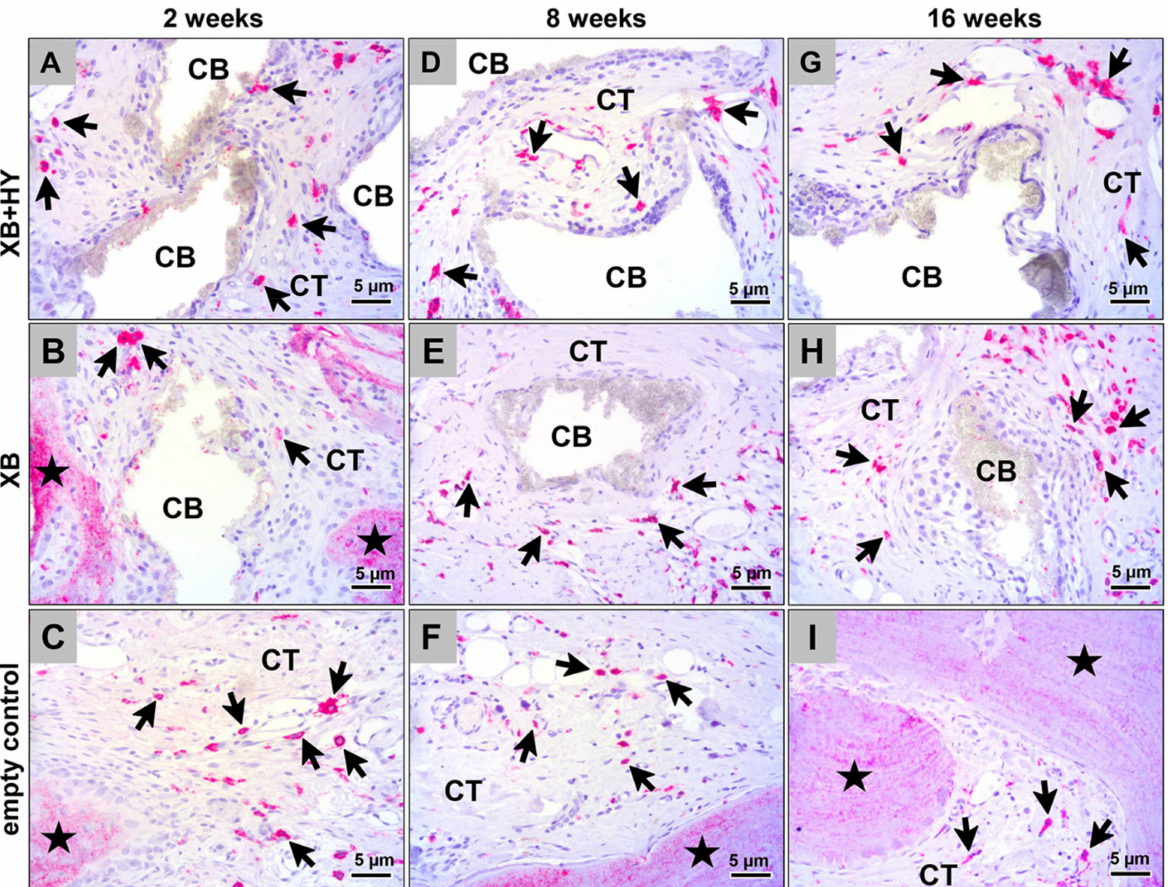
Figure 3. Representative histological images of the anti-inflammatory M2-macrophages within the subcutaneous connective tissue of the different study groups at 2 weeks ( A–C ), 8 weeks ( D–F ), and 16 weeks ( G–I ) post implantationem. Black arrows = M2-macrophages, black asterisk = newly formed bone, CB = granules of the xenogeneic BSM, CT = connective tissue, (CD163-immunostainings, 400 × magnification, scalebars = 5 µ